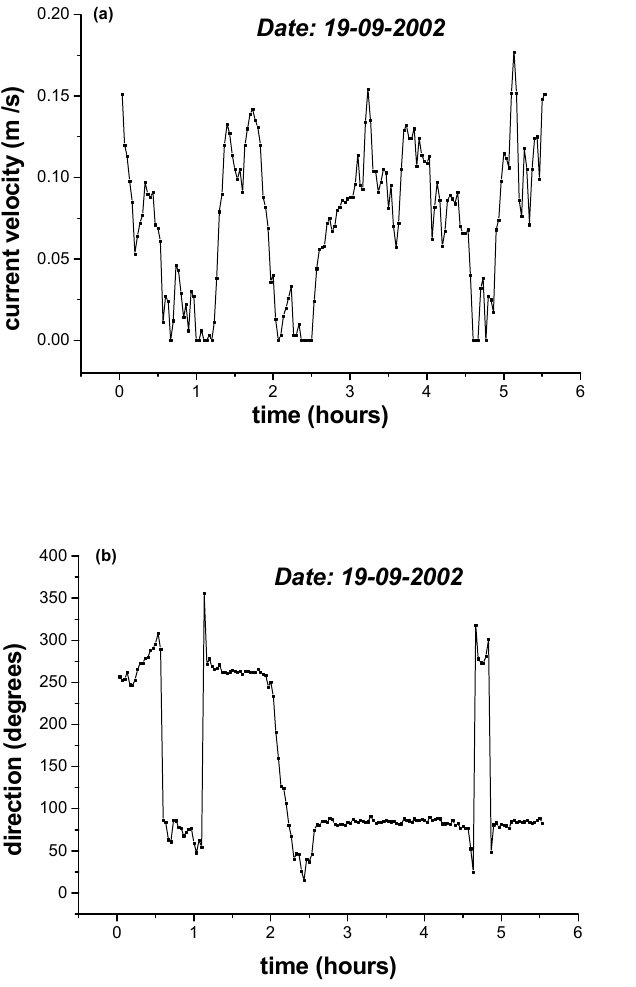
Fig. 5. (a) Current velocity versus time (22 September 2002), (b) Current direction versus time (22 September